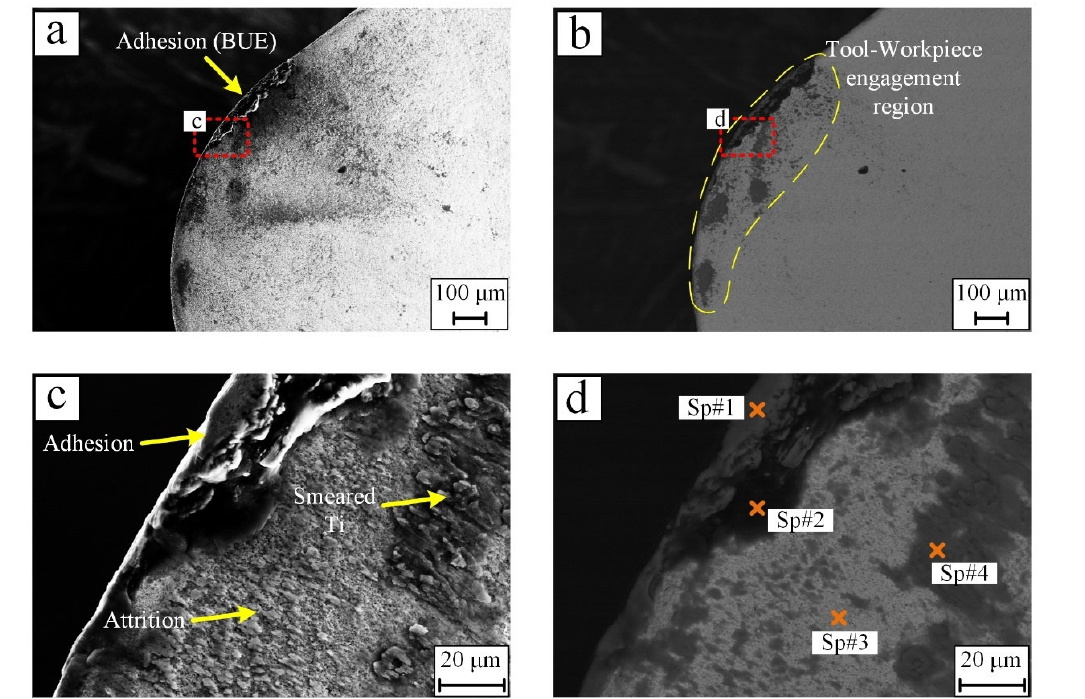
Figure 16. The worn inserts after machining SLMed titanium tubes at a cutting depth of 0.25 mm: ( a ) secondary electron image showing the overview of the worn area, ( b ) backscatter electron image highlighting tool ‐ workpiece contact area, ( c ) enlarged area of shown in ( a ), and ( d ) enlarged area shown in ( b ). Table 5. EDS Spectral analysis of locations identified in Figure 16d.